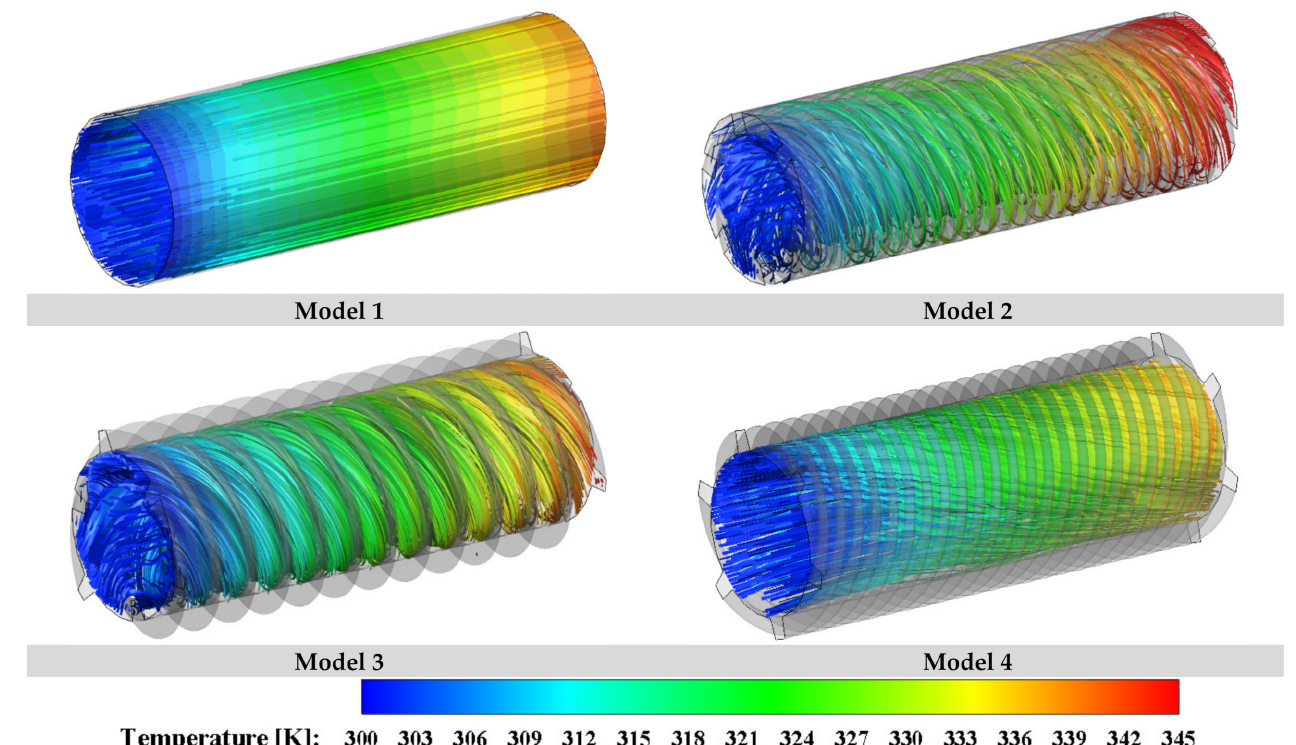
Figure 8. The streamline with contour of temperature for various models at P = 500